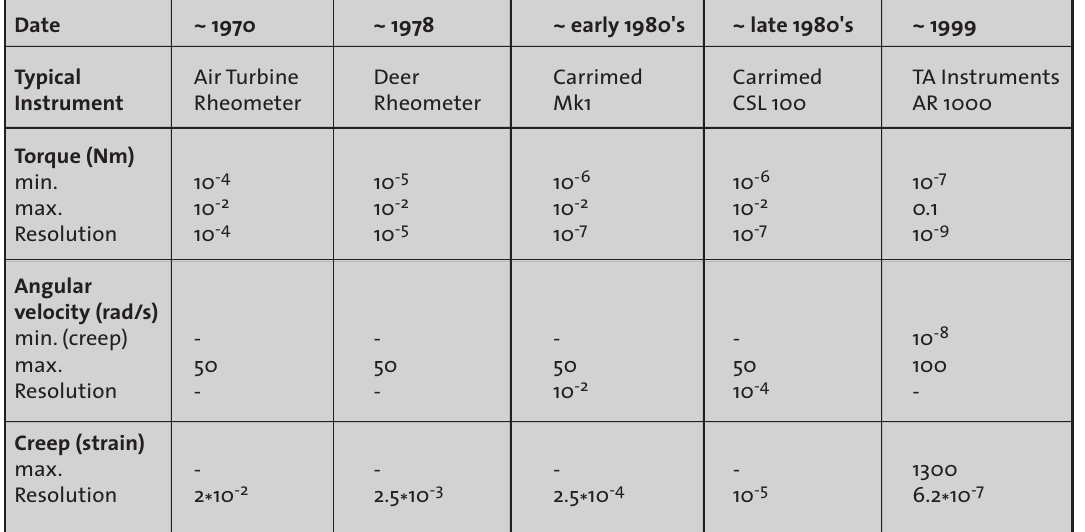
Table 1: Some typical com- mercial controlled-stress rheometer